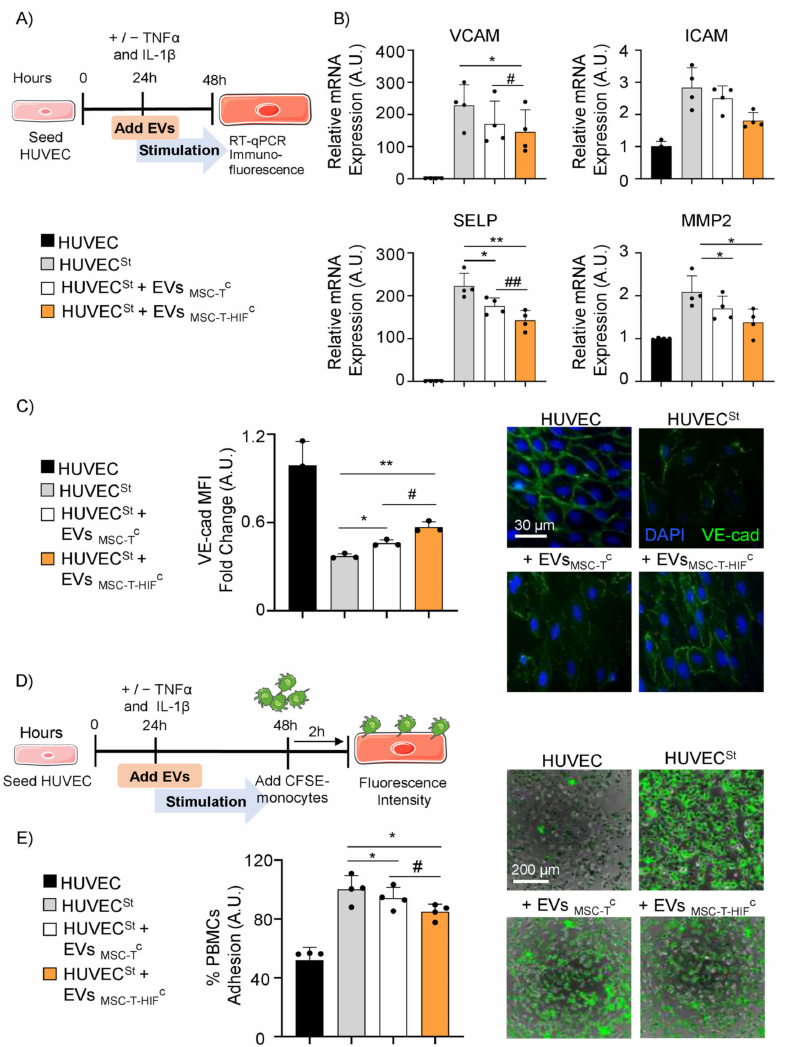
Figure 4. EV MSC-T-HIFC reduce inflammatory responses and peripheral blood mononuclear cell (PBMC) adhesion to activated endothelium. ( A ) Scheme of the in vitro experimental design; ( B ) VCAM, ICAM, SELP and MMP2 expression levels quantified by RT-qPCR in TNF- α - and IL- 1 β -stimulated HUVEC (HUVEC St ). HUVEC St were treated with EV MSC-TC and EV MSC-T-HIFC . Un- stimulated HUVECs were used as a control. Expression level of the target gene in each sample was normalized to GAPDH expression. Graphs represent mean ± SD of fold change of four independent experiments. One-way ANOVA with Geisser–Greenhouse correction was used for statistical analysis. ( C ) Immunofluorescence of VE-cadherin (VE-cad, green) and nuclei staining (blue) to show the distribution of VE-cad in the cell membrane. Scale bar: 30 µ m. Bar graph shows quantification of mean fluorescence intensity (MFI). Relative MFI was calculated by dividing all individual data by the MFI in unstimulated HUVEC. Graph represents mean ± SD of fold change of three independent experiments. One-way ANOVA with Geisser–Greenhouse correction was used for statistical analysis. ( D ) Scheme of the in vitro experimental design. (E) Images of PBMCs (green) adhering to unstimu- lated HUVEC and HUVEC St during 2 h, treated or not treated with EV MSC-TC or EV MSC-T-HIFC . Scale bar: 200 µ m. Percentage of PBMC adhesion was calculated considering the stimulated condition as 100% adhesion. Graph represents mean ± SD of fold change of four independent experiments. One-way ANOVA with Geisser–Greenhouse correction was used for statistical analysis. * or # p < 0.05, ** or ## p <